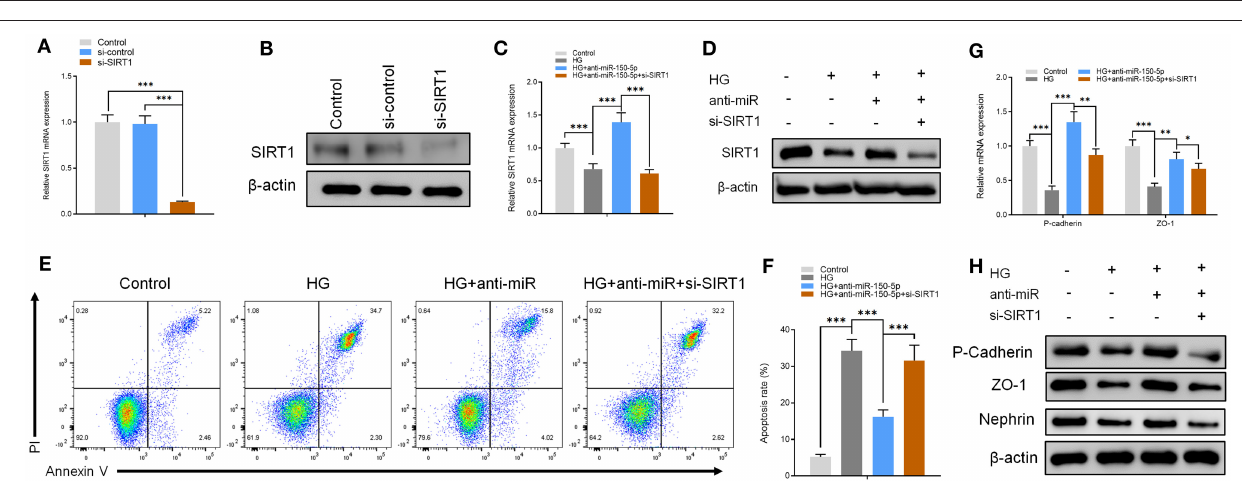
FIGURE 4 | The effect of anti-miR-150-5p is mediated by sirtuin 1 (SIRT1) knockdown. (A,B) The levels of SIRT1 in podocytes were determined using qRT-PCR and Western blot after transfection with si-SIRT1 for 48h. (C,D) The levels of SIRT1 in podocytes were determined using qRT-PCR and Western Blot after transfection with si-SIRT1 and culture in high glucose for 48h. (E,F) Quantification and analysis of apoptosis rates using flow cytometry in podocytes after transfection with si-SIRT1 and culture in high glucose for 48h. (G,H) The levels of P-cadherin and zonula occludens-1 (ZO-1) in podocytes were determined using qRT-PCR and Western blot after transfection with si-SIRT1 and culture in high glucose for 48h. Data are expressed as mean ± SEM ( n = 3; * p < 0.05, ** p < 0.01, *** p < 0.001).